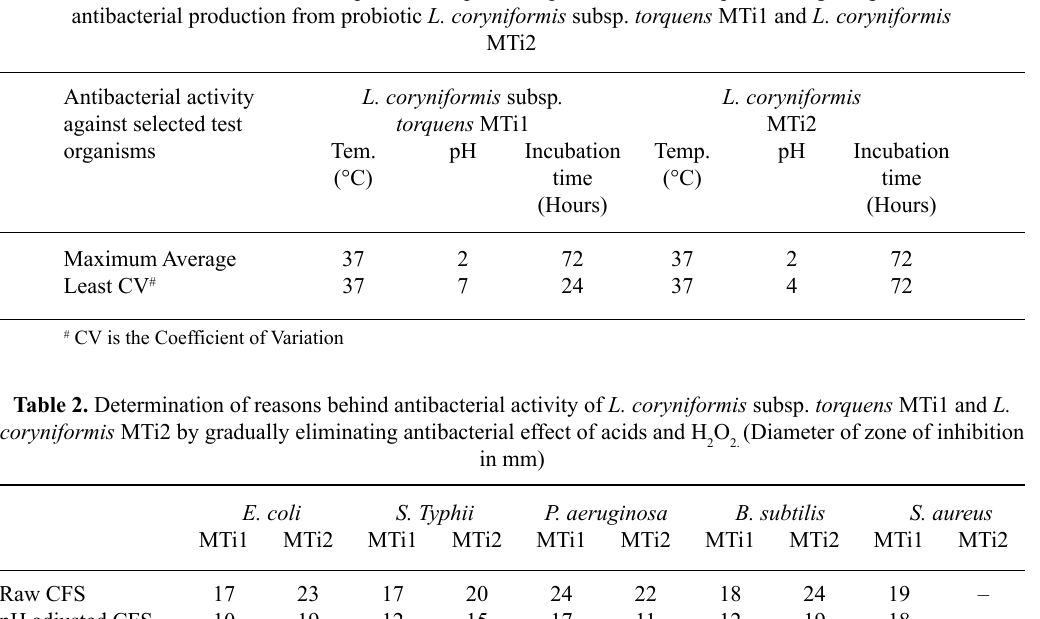
Table 1. Determination of optimum temperature, pH and incubation period for getting best